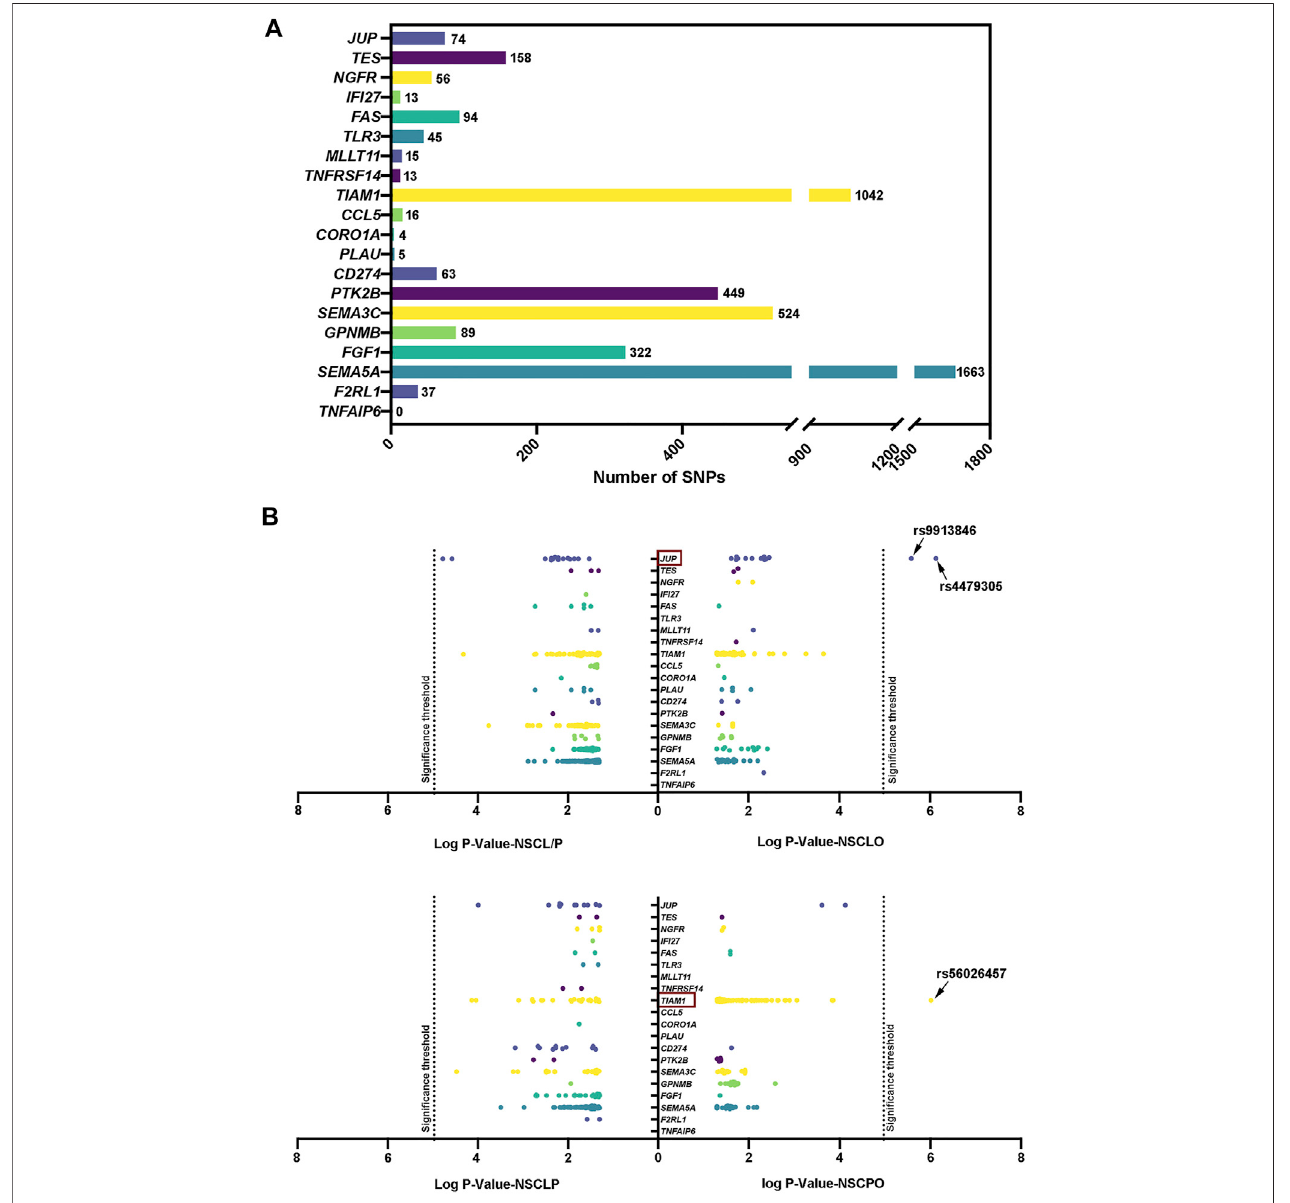
FIGURE 3 | (A) Number of SNP within genes associated with the terms “ apoptotic signaling pathway, ” “ regulation of cell proliferation, ” and “ positive regulation of cell migration; ” (B) RecruitedSNPs with p value pass .05. Log p value withbase 10are shown in the fi gure. The5.42E-05signi fi cance thresholdin thereplicationphase was adjusted by multiple